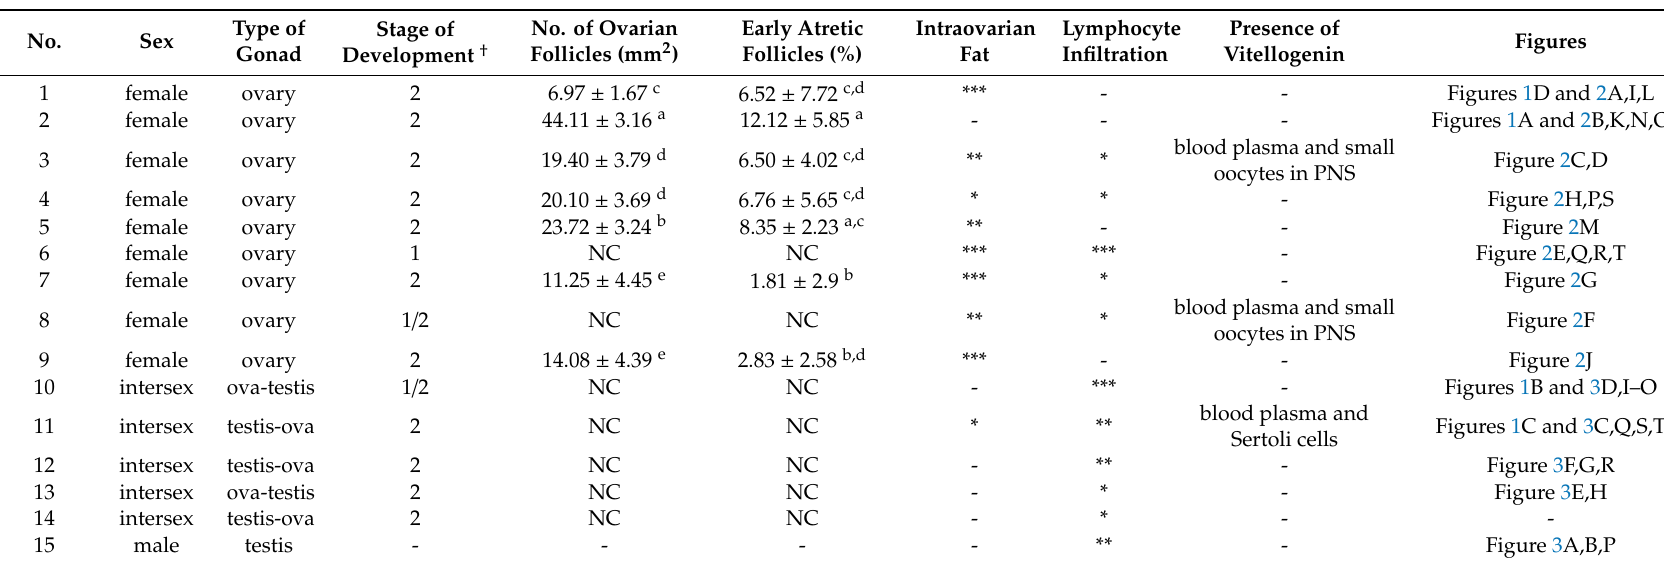
Table 1. Characteristic of the ovarian component of recirculating aquatic system (RAS)-reared Russian sturgeon on the 1600th day after